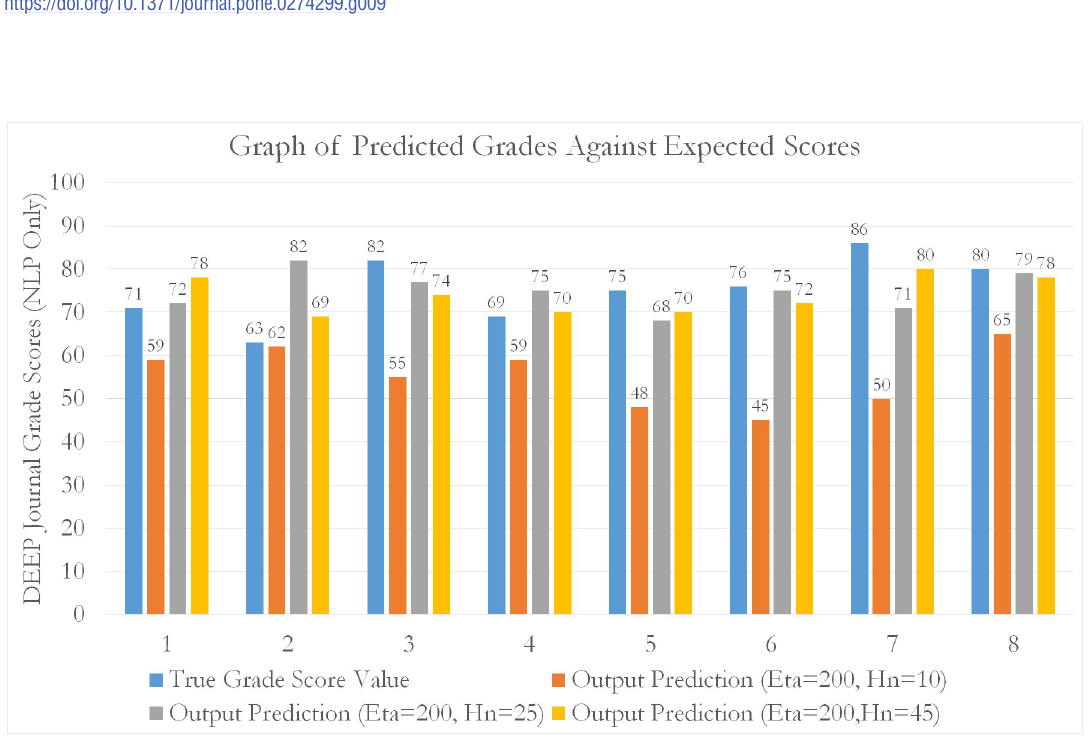
Fig 10. A bar chart showing the distribution of predictions of student grade scores against expected (real) grade scores awarded by course assessors. The predictions were made through MLP, based on the NLP features.